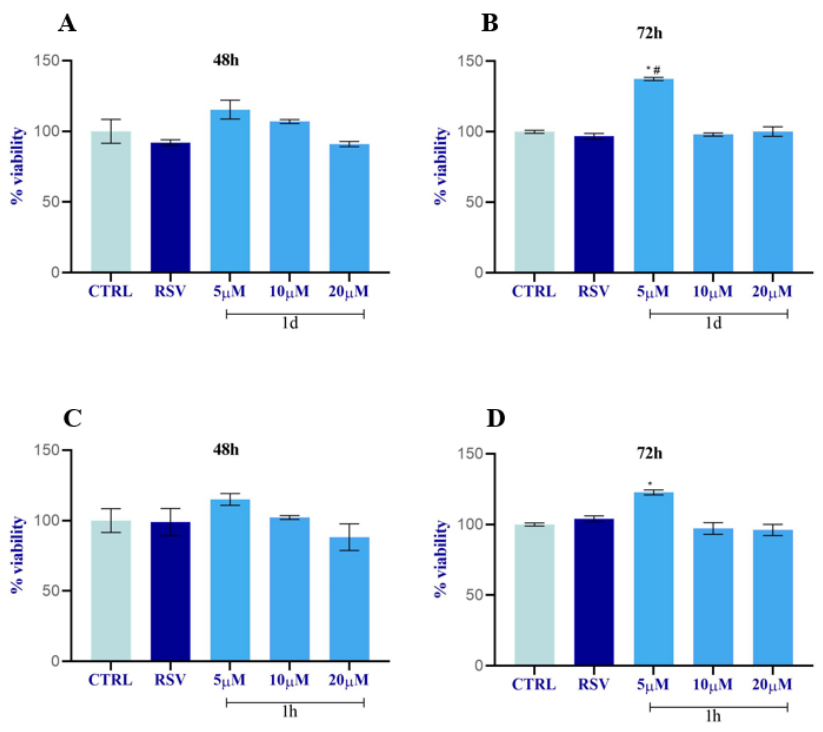
Figure 6. HOBs viability percentage after treatment with 1d ( A , B ) and 1h ( C , D ). Data were calculated as means ± SD and compared to CTRL (cells treated with 0.1% DMSO); RSV: cells treated with 10 µ M of RSV. * Significance in respect to CTRL: * p < 0.05; # Significance in respect to RSV and 1d and 1h : # p < 0.05